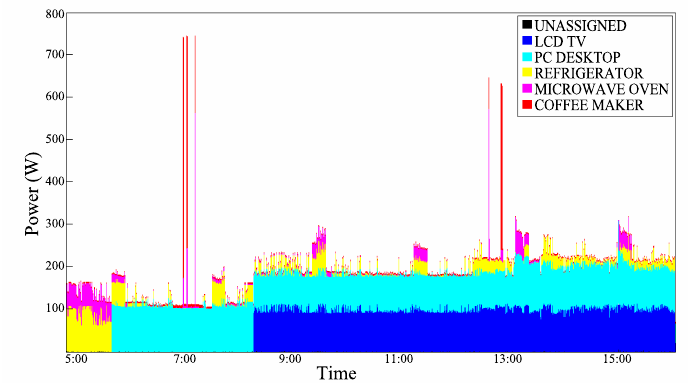
Figure 8. Power consumption trace disaggregated with the Usage Statistics Conditioning (USC) —test case 1.